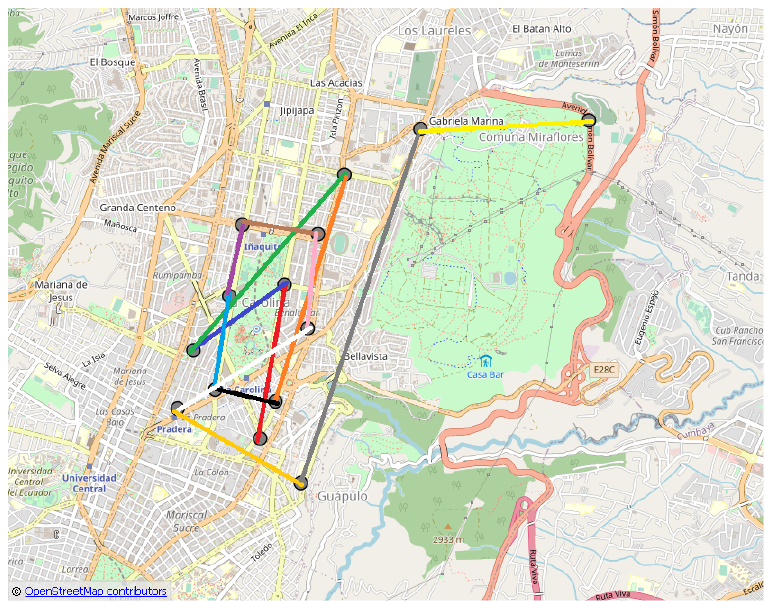
Figure 14. Way-points sequence obtain by the Fuzzy Decision-Making System (gray circles are way-points and color lines are the routes, Table